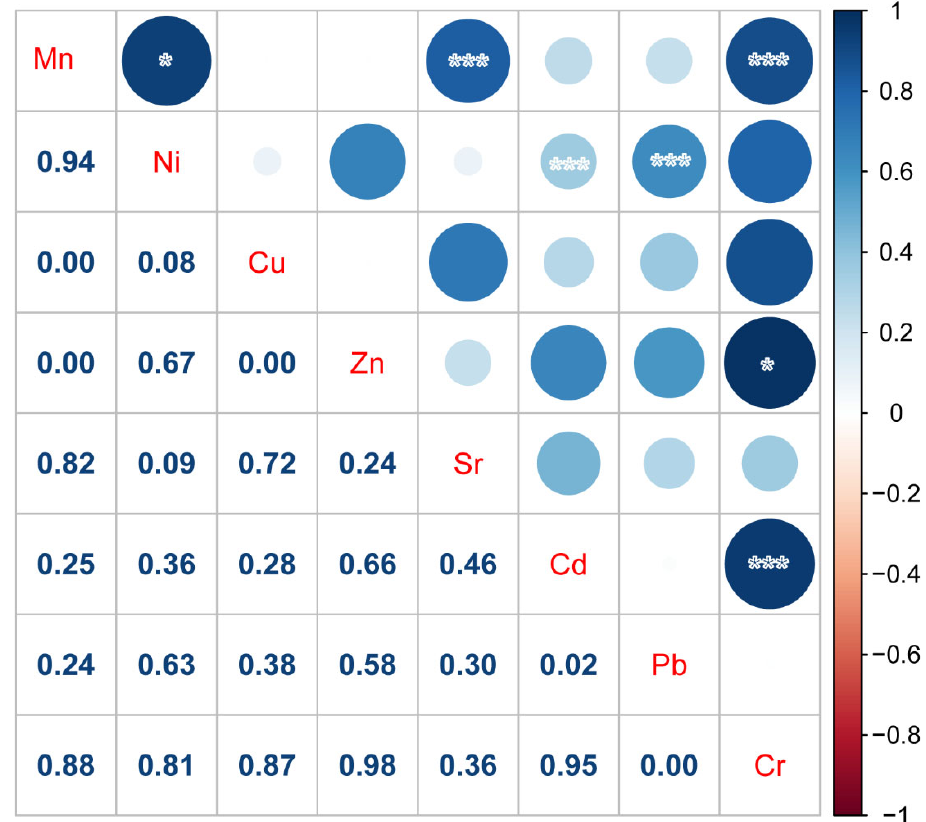
Figure 4. Correlation analysis of eight heavy metals in the poultry farm area. Significant correlation (* p ≤ 0.05); (*** p ≤ 0.001). Table 4. Heavy metal concentrations in shallow groundwater in previous studies carried out in world